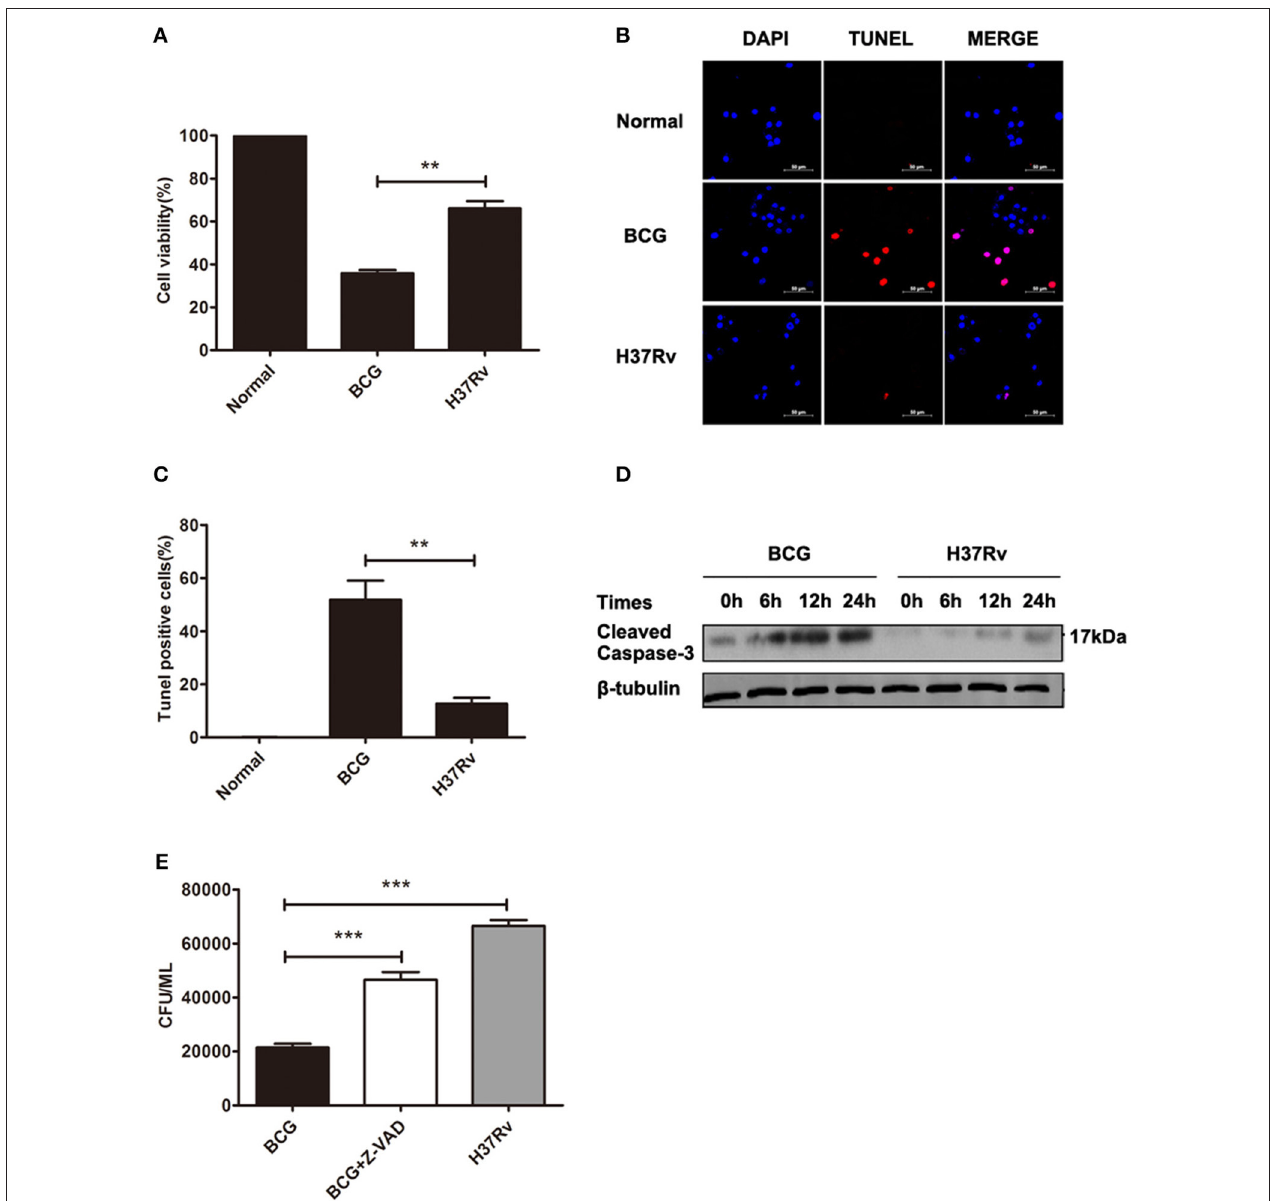
FIGURE 1 | Different levels of apoptosis were induced by H37Rv and BCG infections, which led to distinct bacillary loads in macrophages. (A) RAW264.7 cells were infected with H37Rv or BCG (MOI = 10) for 24h, and cell viability was determined by CCK8 assays. (B) DNA fragmentation was observed by TUNEL assays. The scale bars indicate 50 µ m. (C) The percentages of apoptosis in TUNEL assays. (D) RAW264.7 cells were infected with H37Rv or BCG (MOI = 10) for 6, 12, and 24h, and cleaved caspase-3 was measured by western blot. (E) RAW264.7 cells were infected with H37Rv, BCG, or BCG (MOI = 10) pretreated for 1h with Z-VAD (20 µ M) for 8h, and CFU counting of intracellular viable bacteria was performed for 2 days. Data are performed as the mean ( ± SEM) and from one representative experiment of three independent experiments. (** p < 0.01; *** p <